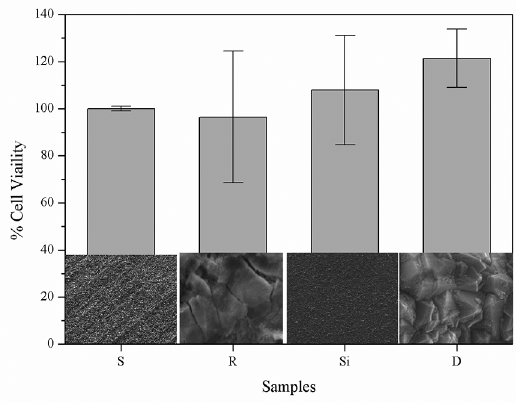
Figure 8. Scatter plot for MC3T3-E1 (mouse pre-osteoblastic) cells viability. The cells were cultivated on Ti6Al4V surface without treatment (S; negative control), rough Ti6Al4V (R), rough Ti6Al4V covered with diamond film (D) or a silicon substrate covered with a diamond film (Si). Absorbance values were converted to percentage, and the negative control (Ti6Al4V without treatment) represents 100% of cell viability. The results presented include data for three independent experiments with three (S and R) or six (D and Si) samples each.